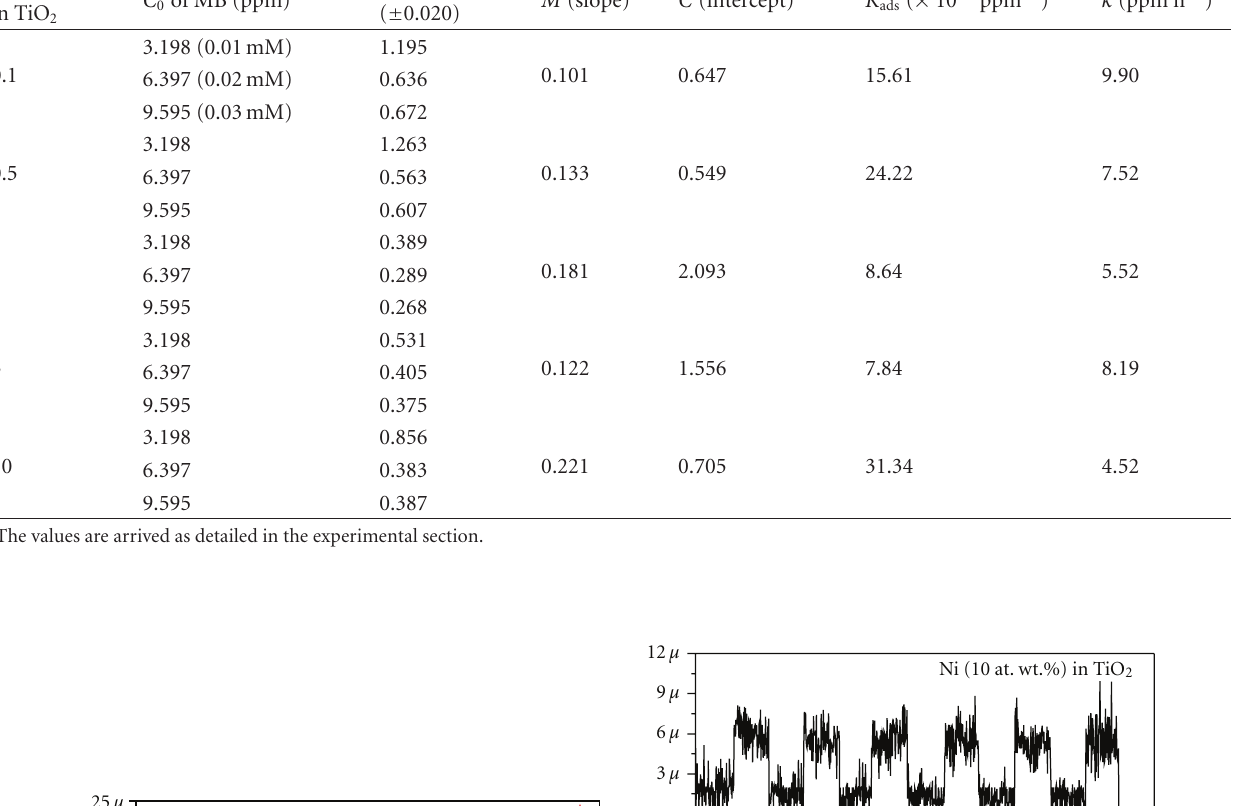
Table 3: The initial concentrations of methylene blue (MB), the initial degradation rate ( r ), the Langmuir-Hinshelwood adsorption equilibrium constant ( K ads ), and the pseudo-first-order rate constant ( k ) of methylene blue over Ni-doped TiO 2 (Ni = 0.1, 0.5, 1, 5, and 10 at. wt.%) powders formed at 550 ◦ C for 6h. † Ni (at. wt.%)